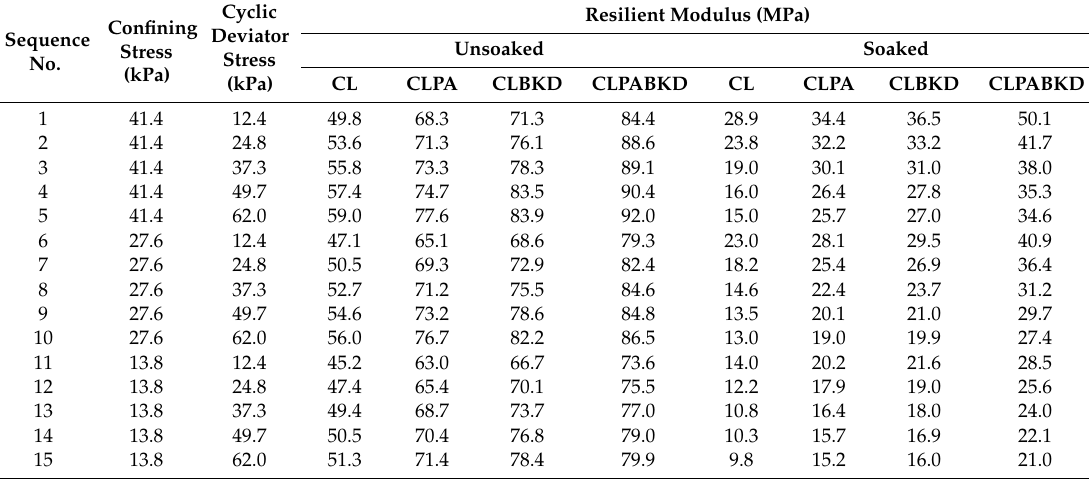
Table 8. Resilient modulus of optimum waste-geomaterial mixtures.